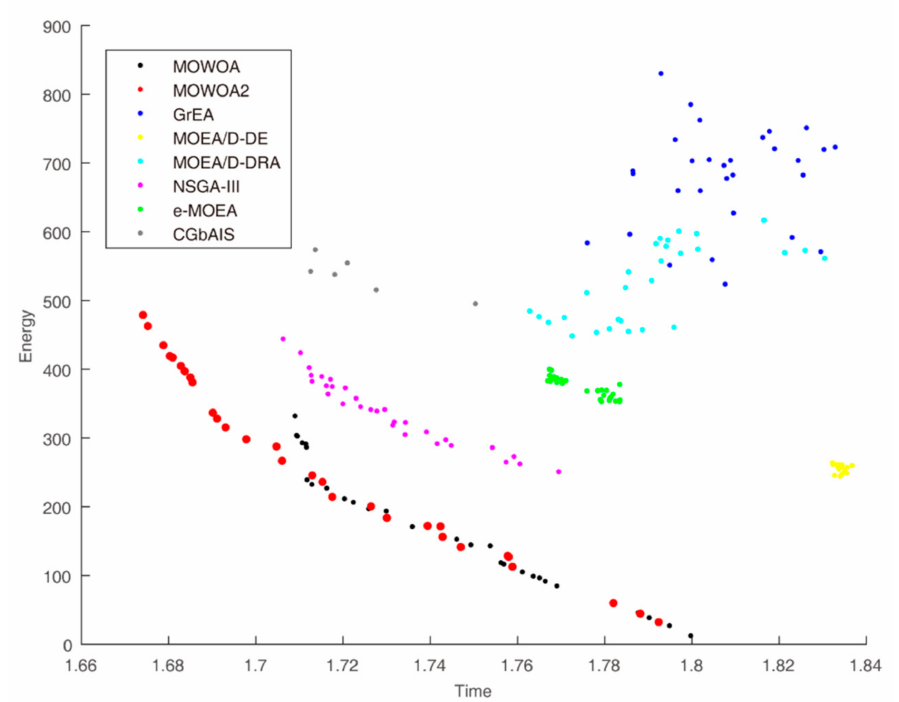
Figure 4. Time and energy consumption of the different algorithms when the user number is 45.